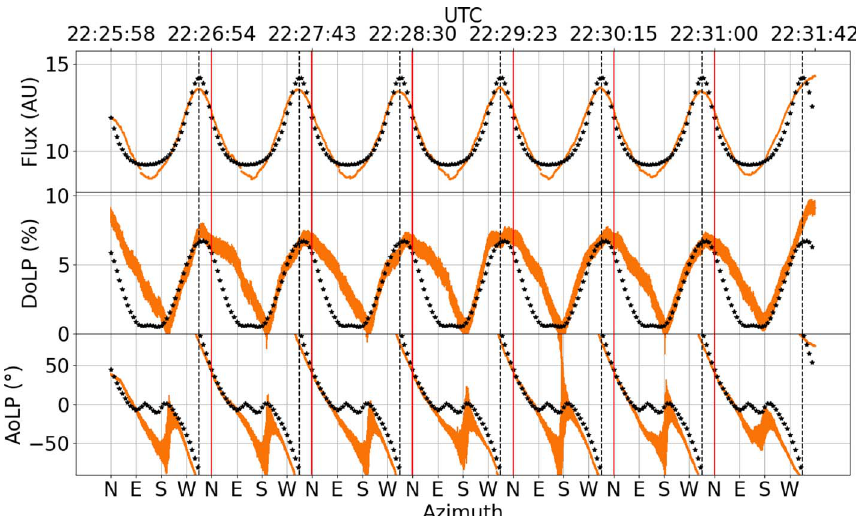
Fig. 6. Same as Figure 5 for the aerosols pro fi le offering the best fi t to the data (see text for